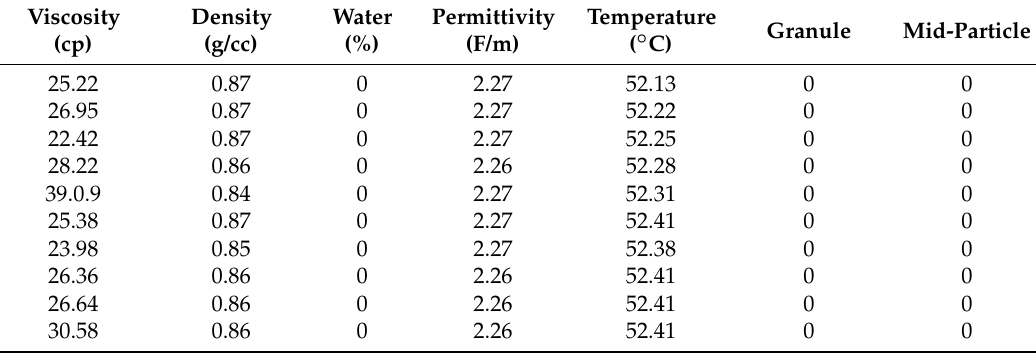
Table 1. Part of online oil monitoring data during grinding of